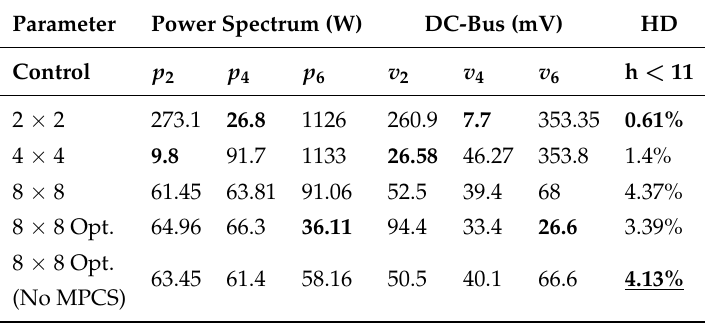
Figure 6. Steady-state analysis of each configuration by means of—( a ) FFT of measured power at the PCC; ( b ) FFT of the DC-BUS voltage (Zoom in low values); ( c ) FFT of the three-phase current at the PCC (Zoom in low values). Table 3. Simulation